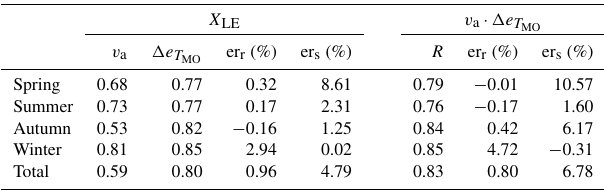
Table 4. Results of the stepwise linear regression model X LE for the latent heat flux. The corresponding correlation coefficient ( R ) of the model after a variable is added to the model is shown. For the model with v a · (cid:49)e MO , the correlation coefficient ( R ) is given. The prediction errors yielded by the MCCV with randomly chosen validation data points (er r ) and randomly chosen validation sectors (er s ) are shown for both models. Results are shown for the meteo- rological seasons and for the entire data set.